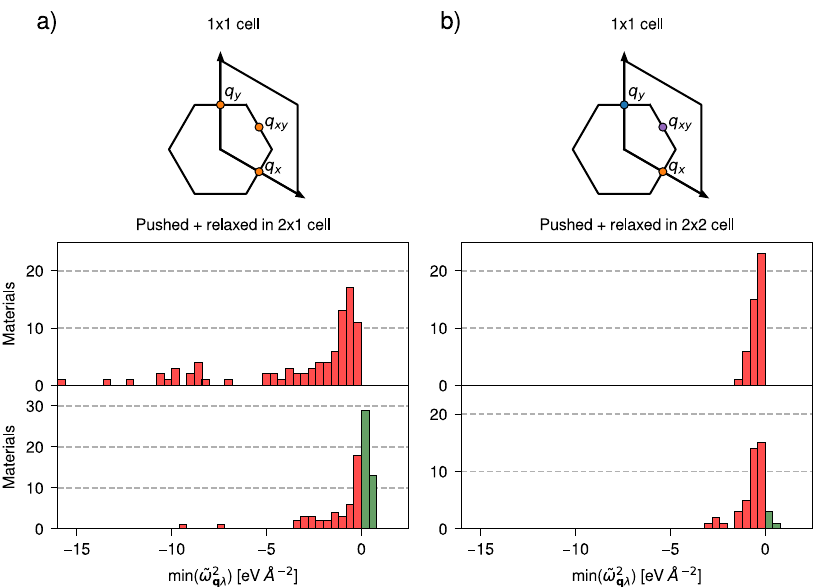
Fig. 4 Histograms of minimum eigenvalues of the Hessian matrix before and after displacing along the unstable mode. The 137 dynamically unstable 2D materials studied in this work can be divided into two groups depending on whether the minimum eigenvalues of ; 0 Þ ; ð 0 ; 1 ; 1 the Hessian matrix ~ ω q λ at q ¼ fð 1 Þ ; ð 1 Þg are equal (panel a orange) or different (panel b different colors). For the fi rst group of 2 2 2 2 ; 0 Þ and relaxed in a 2 × 1 supercell. Starting from 91 unstable materials (red), 43 materials, the atoms are displaced along the mode at q ¼ ð 1 2 ; 1 (green) become stable. For the second group, displacing along q ¼ ð 1 Þ and relaxing in a 2 × 2 supercell, yields a dynamically stable structure 2 2 in 6/46